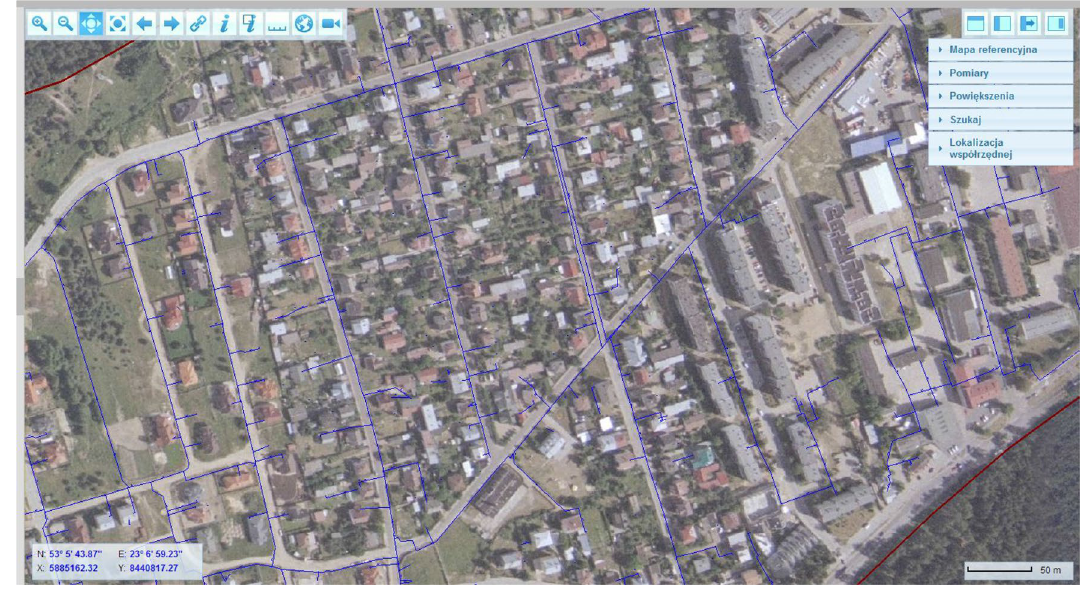
Fig. 2 Fragment of a digital map of the Kleosin network with an aerial photograph layer